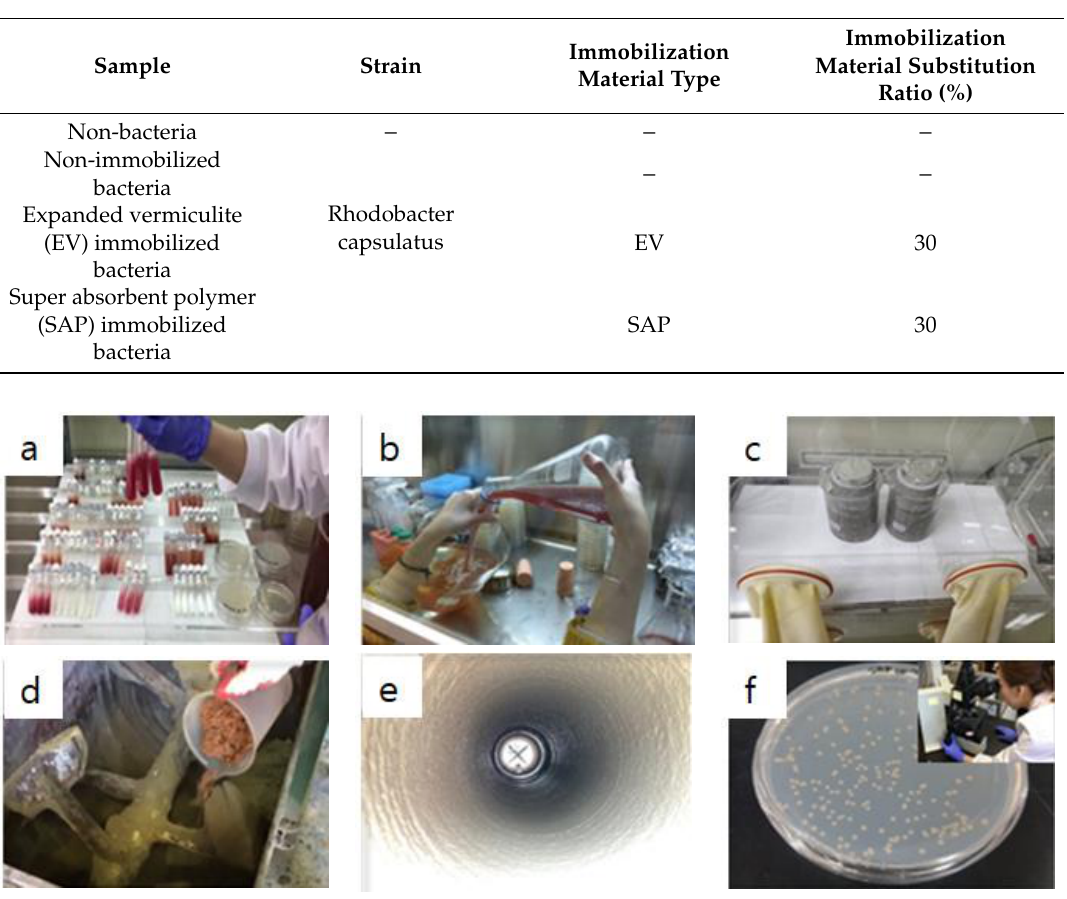
Figure 1. Procedures for producing bio-slime with bacteria and coating for sewage line: ( a ) bacteria lsolation and screening; ( b ) bacteria culture: 10 9 cell / mL. (pH = 6.8, anaerobic environment); ( c ) bacteria immobilization; ( d ) coating material formulation; ( e ) coating material construction by lining method; ( f ) confirm bacterial growth (recultured and microscopic).